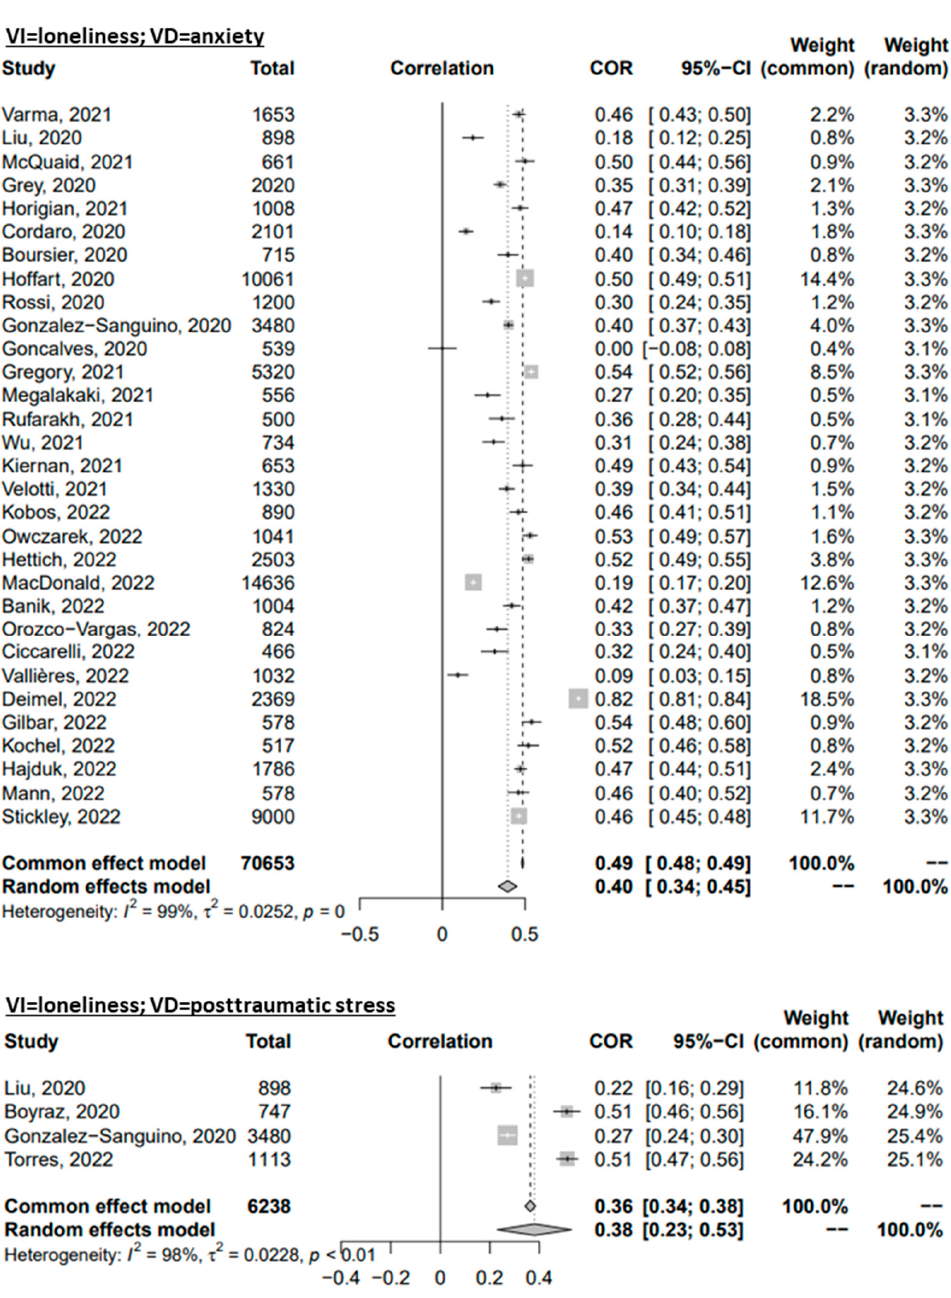
Figure 2. Forest plot of the Omnibus Test for the correlations of loneliness with mental disorder